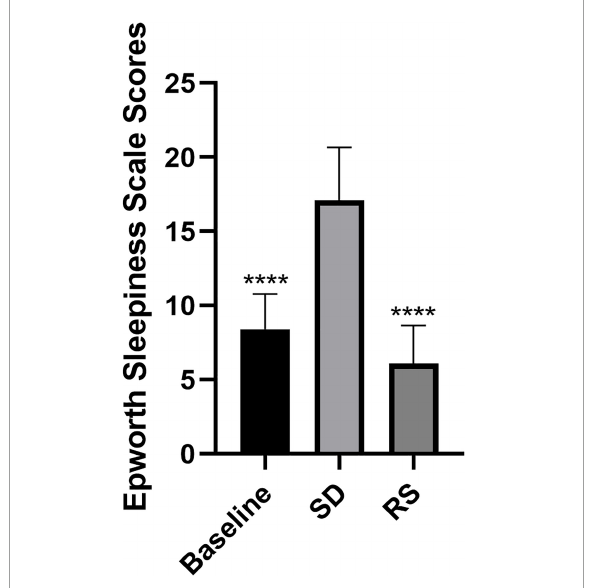
FIGURE2 Epworth sleepiness scale scores. Subjects were scored on the Epworth sleepiness scale at three time points. Sleep deprivation significantly increased subjects’ daytime sleepiness compared to baseline, and this was significantly reduced after recovery sleep. **** P < 0.0001 compared to